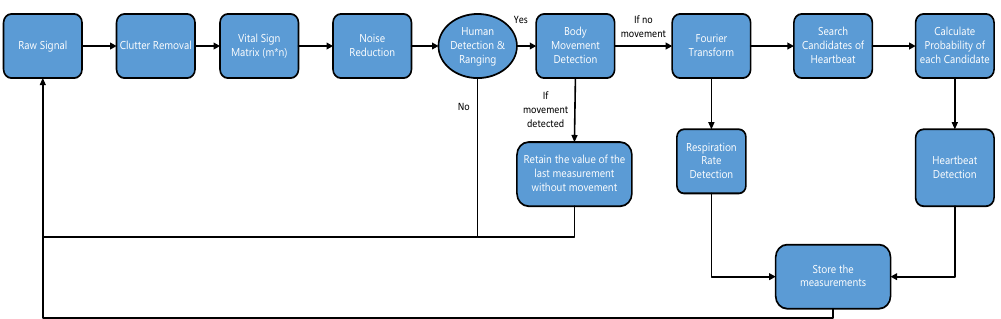
Figure 1. Experimental setup.